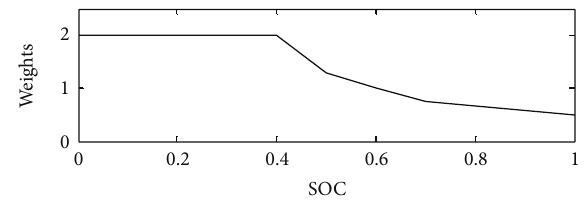
Figure 3: SOC weighting factor 𝑓( SOC ) for optimal control.